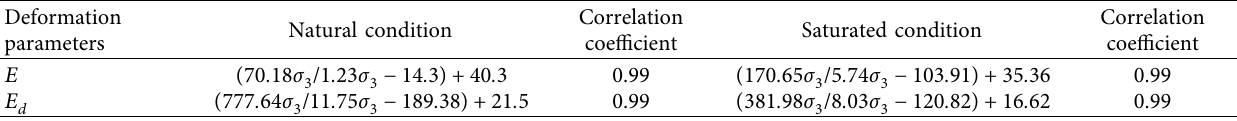
Table 3: Fitted formulas for elastic modulus and deformation modulus of Yunnan limestone under natural and saturated conditions. Deformation parameters